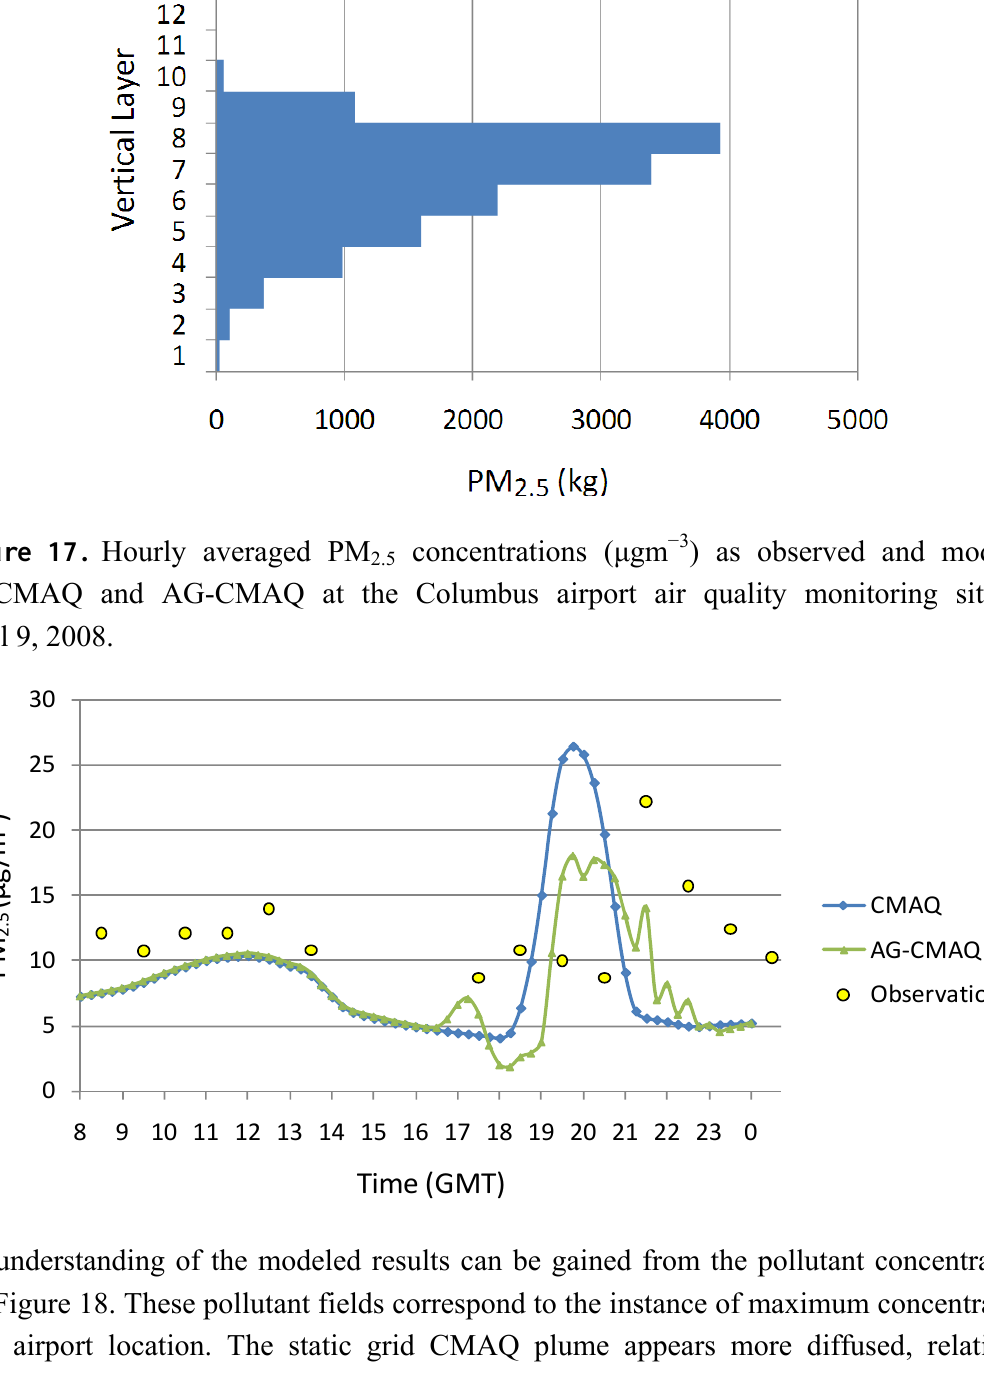
emissions into CMAQ and 2.5